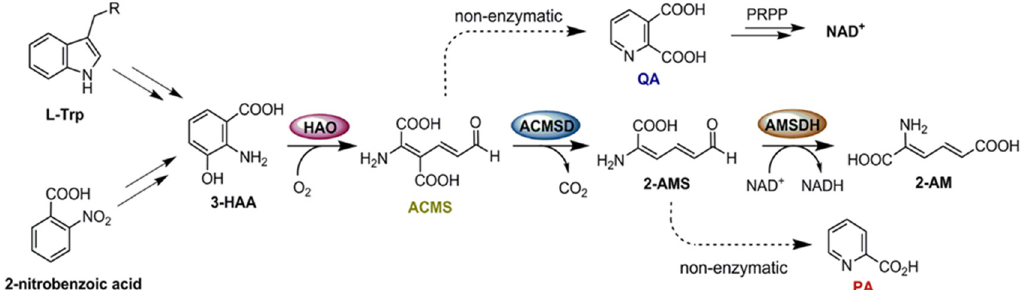
Figure 1. The L-tryptophan kynurenine pathway (KP) and the bacterial 2-nitrobenzoic acid